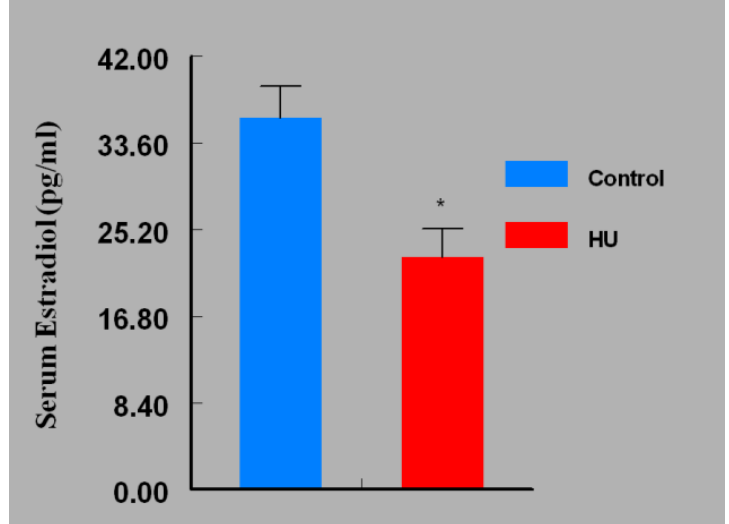
Figure 3. Effect of HU on Serum E Concentrations in Female Mice Treated IP with 30 2 mg HU/kg for 28 days; n = 5 per Group. Results are expressed as mean ± SE (HU = treated mice; Control = vehicle treated mice. Asterisks indicate a significant difference from controls ( P <